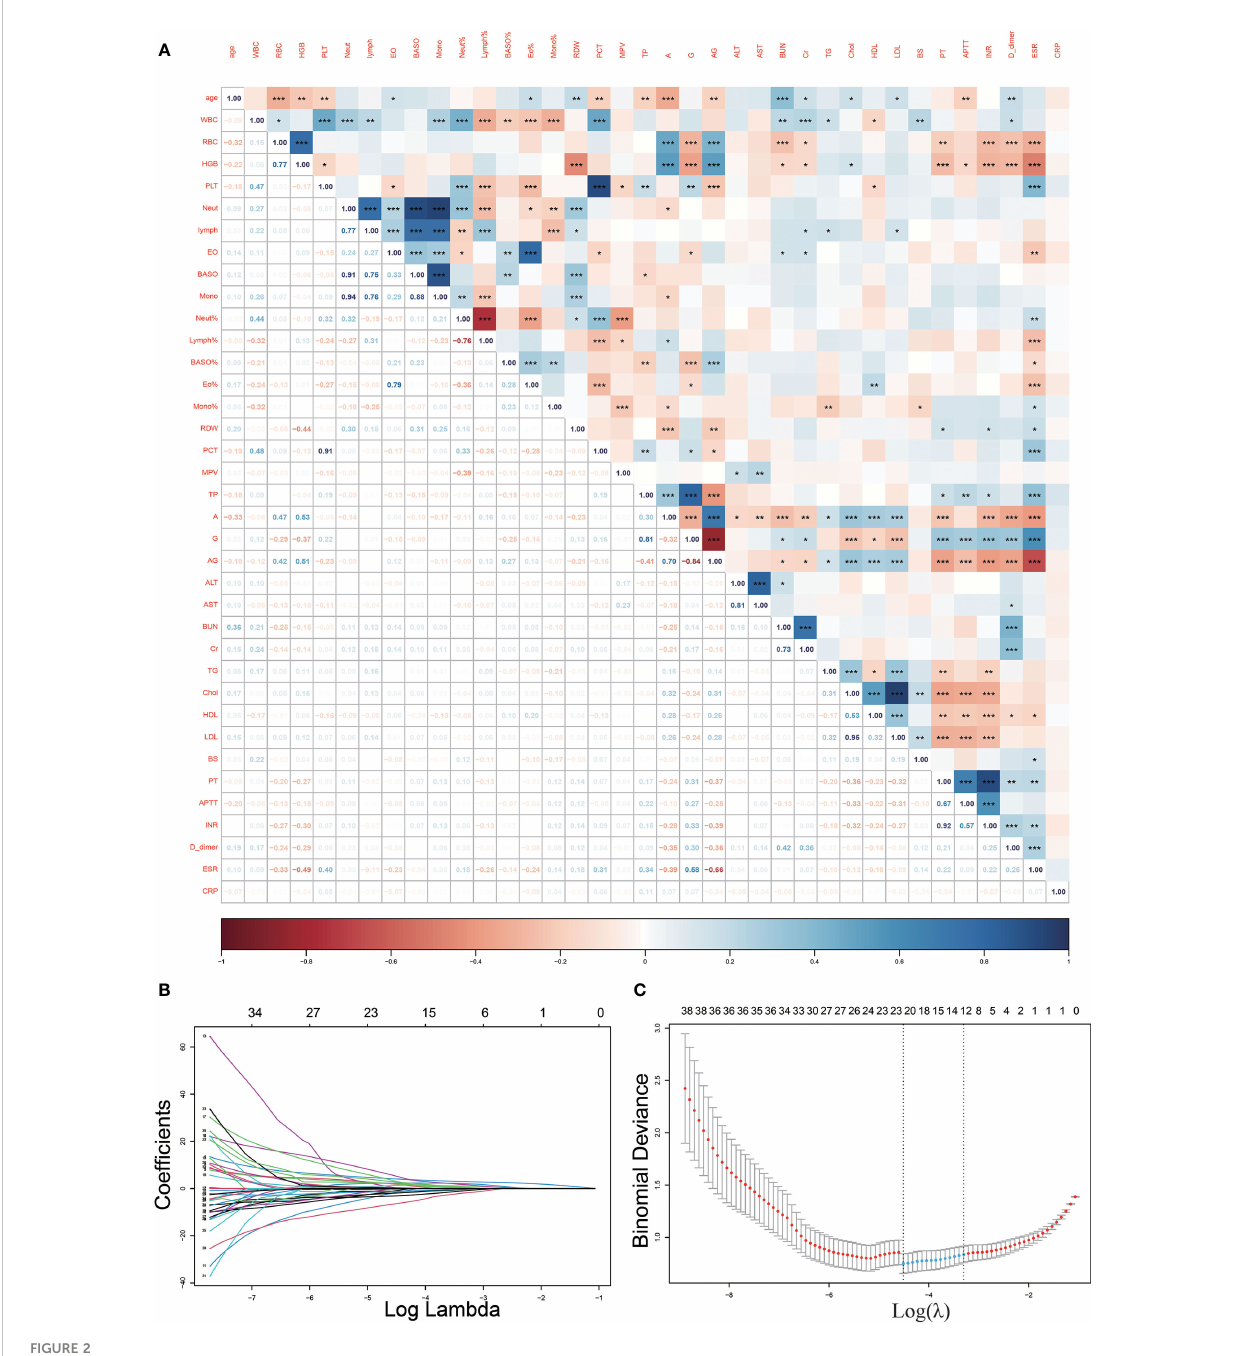
FIGURE 2 Heat map of correlations between variables and Lasso regression screening variables. (A) , The heat map of correlations between continuous variables demonstrates the existence of covariance between many variables (*p<0.05, **p<0.01; ***p<0.001); (B, C) , Lasso regression fi ltered out 12 variables from the